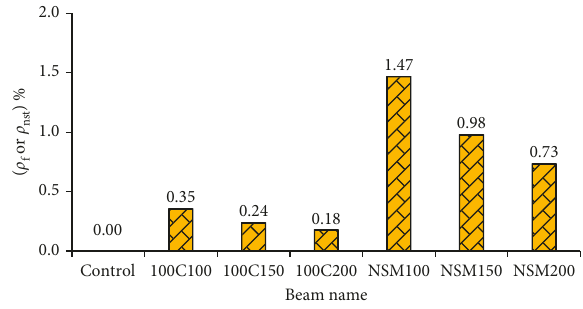
Figure 5: CFRP sheet and NSM steel reinforcement ratios for the strengthened